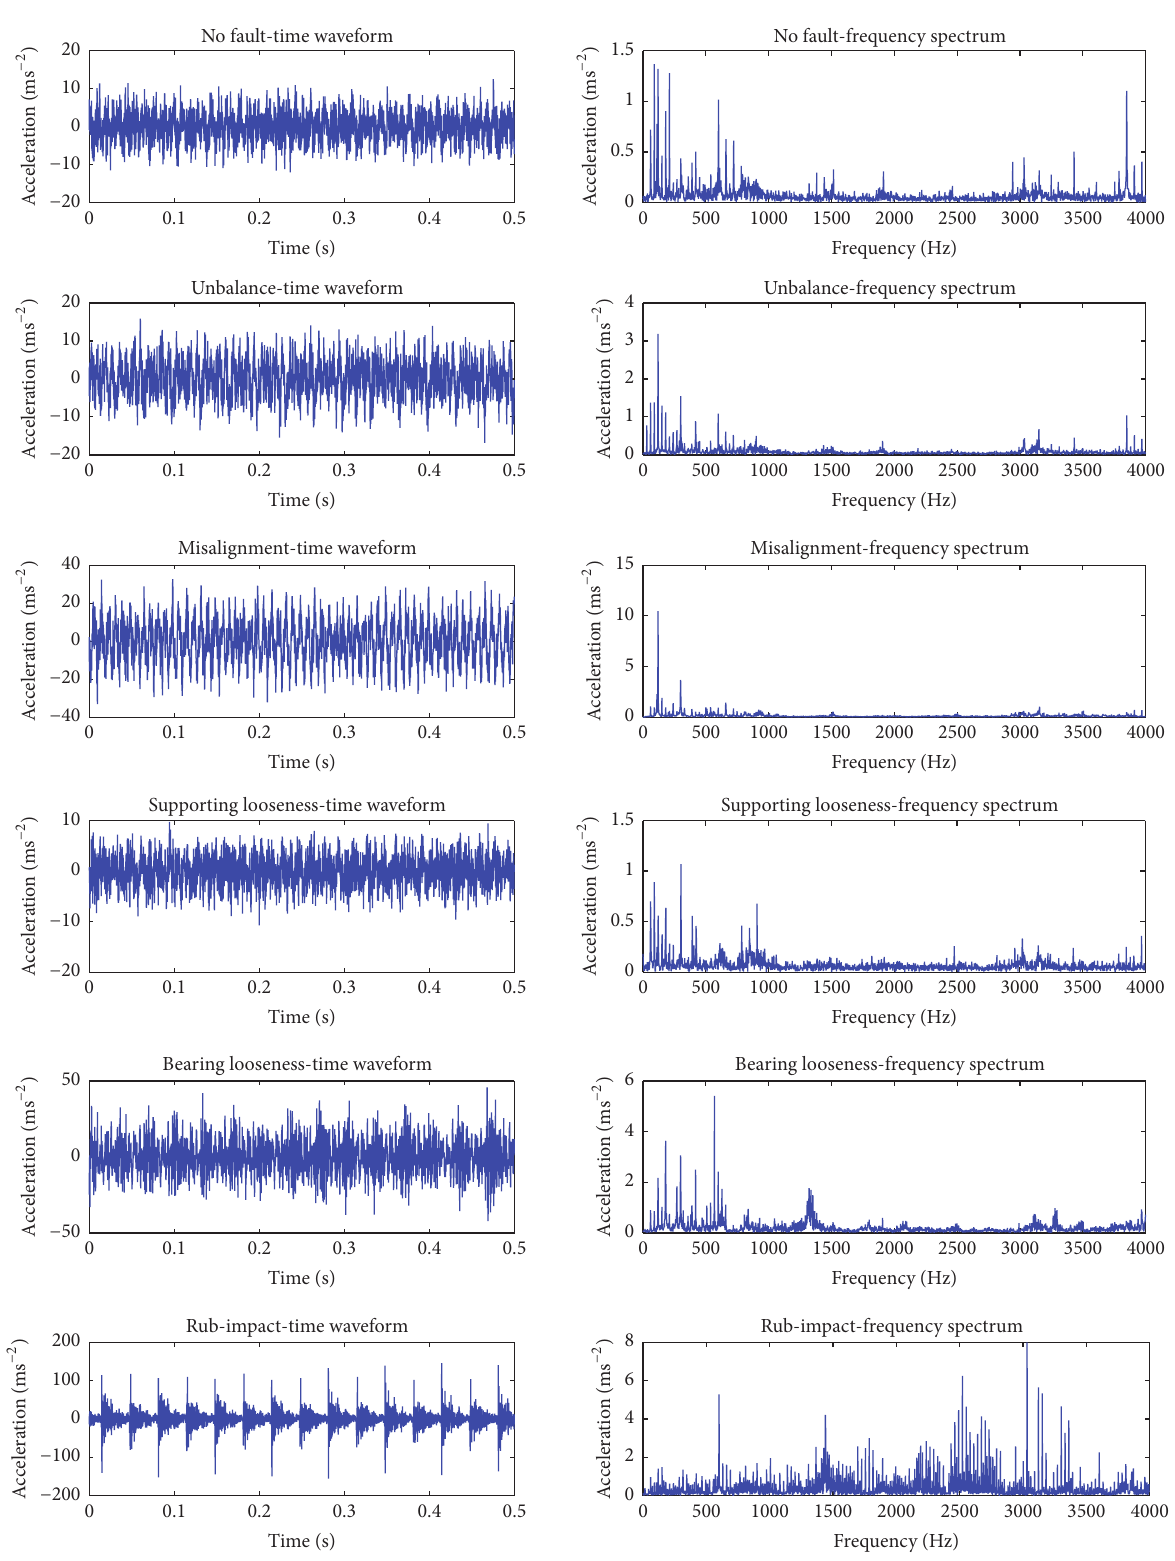
Figure 6: Time waveforms and frequency spectrums for no fault, unbalance, misalignment, supporting looseness, bearing looseness, and